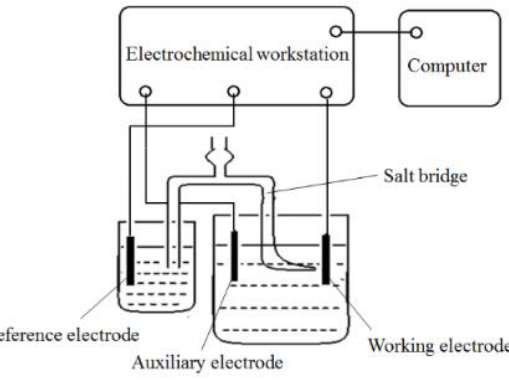
Figure 3. Diagram of the electrochemical test circuit and system.